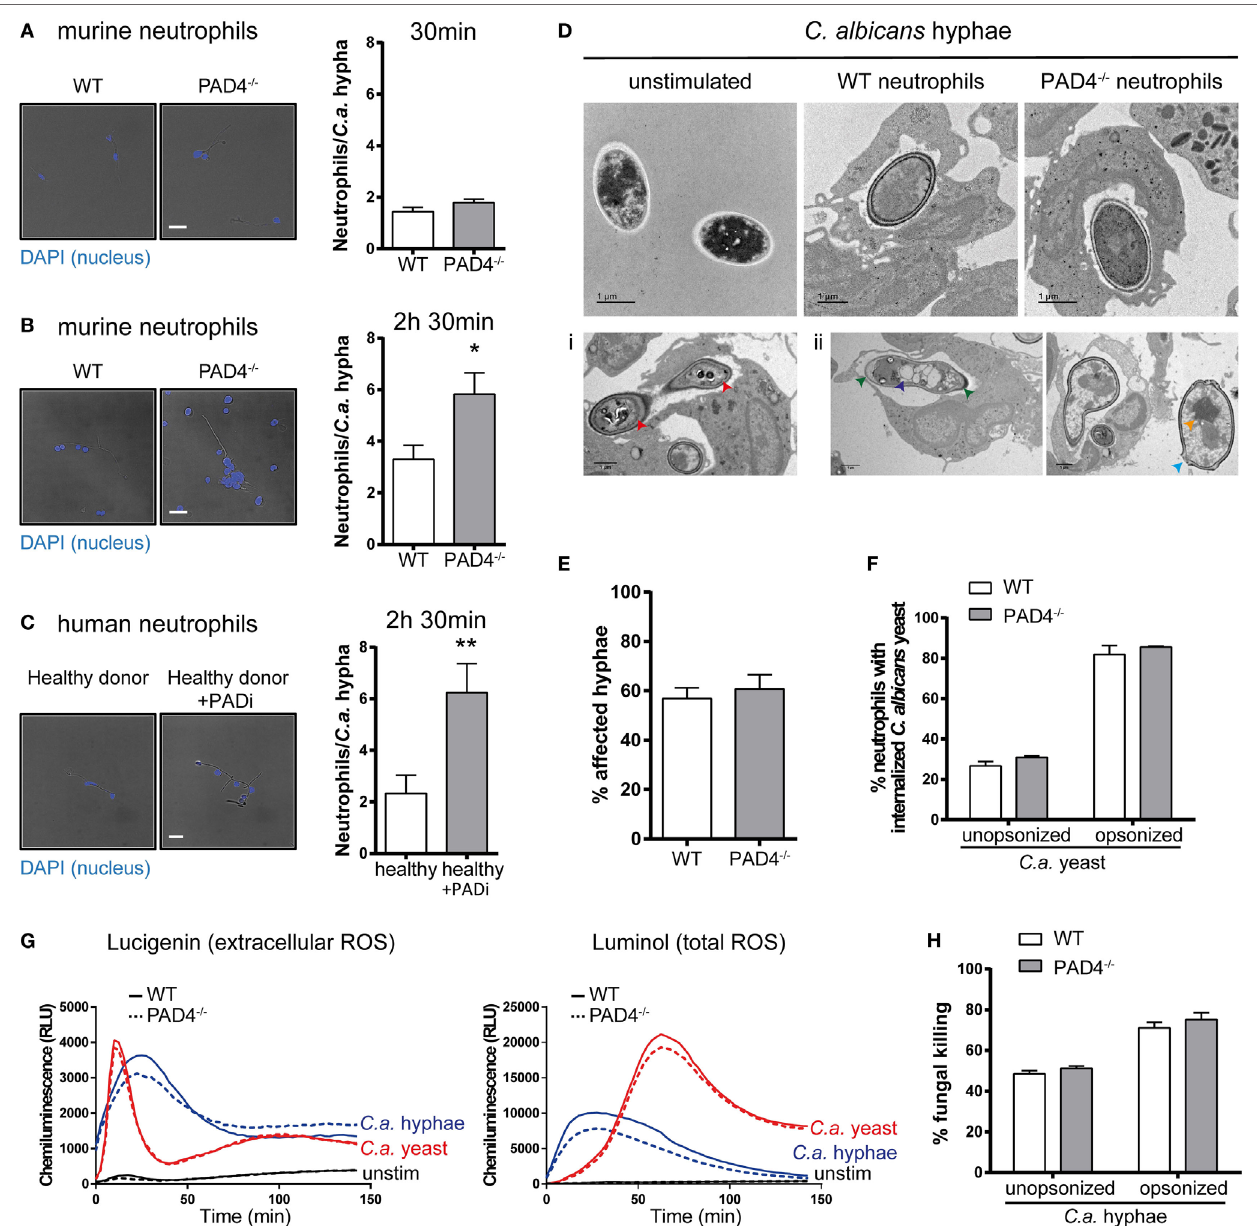
FigUre 4 | Peptidylarginine deiminase 4 (PAD4)-deficiency results in increased clustering of neutrophils to Candida albicans hyphae but does not affect their antifungal activity. (a–c) Neutrophils were isolated from the bone marrow of naïve WT and PAD4 − / − mice (a,B) or from peripheral blood of a healthy donor and treated or not with the PAD inhibitor Cl-amidine (c) . Neutrophils were incubated with C. albicans hyphae and then stained with DAPI (blue). The number of neutrophils interacting with each C. albicans hypha was quantified after 30 min (a) or 2.5 h (B,c) of stimulation. Representative images are shown on the left (Scale bar = 20 µm), summary plots are shown on the right. Bars are the mean with standard error of the mean (SEM) of each group with n = 2–3. (D) The cell wall integrity of C. albicans hyphae was assessed by transmission electron microscopy after 2.5 h incubation with WT or PAD4 − / − bone marrow neutrophils. Representative images of each group are shown in the upper row. Lower row: some hyphae exposed to neutrophils showed membrane retraction and extensive cytoplasm disintegration (Di) or vacuolation, nuclear alterations, and swelling of the cell wall (Dii) . Scale bar = 1 µm. (e) The frequency of C. albicans hyphae that were affected by WT and PAD4 − / − neutrophils as described in (Di,Dii) was quantified. Bars are the mean with SEM of fungal elements from 18 EM images analyzed per condition. (F) WT and PAD4 − / − bone marrow neutrophils were incubated with GFP-expressing C. albicans yeast cells and the degree of Candida uptake was determined by flow cytometry. Bars are the mean with standard error of the mean (SEM) of each group with n = 2. (g) Reactive oxygen species (ROS) production by WT and PAD4 − / − bone marrow neutrophils in response to C. albicans yeast or hyphae was detected by chemiluminescence using the cell-impermeable substrate lucigenin to detect extracellular ROS (left) or the cell-permeable substrate luminol to detect total ROS (right). (h) WT and PAD4 − / − bone marrow neutrophils were incubated for 3 h with opsonized or unopsonized C. albicans hyphae. The percentage of C. albicans killing was assessed by alamar blue assay. Bars are the mean with SEM of each group with n = 4. Data are pooled from (a,B,h) or representative of (g) two independent